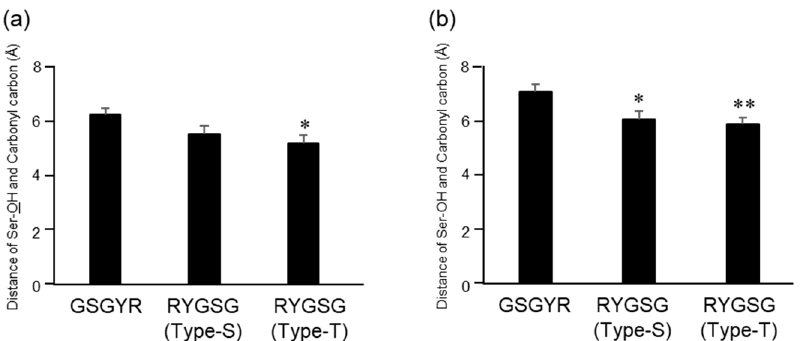
Figure 6. Comparison of the distance between the Ser-OH of each 5-mer peptide and the carbonyl carbon of the cleavage site. ( a ) Carbonyl carbon of 17Leu, ( b ) carbonyl carbon of 22Glu. Data are presented as mean ± SEM. n = 10. * indicates p < 0.05 and ** indicates p < 0.01 versus A β 11-29 .